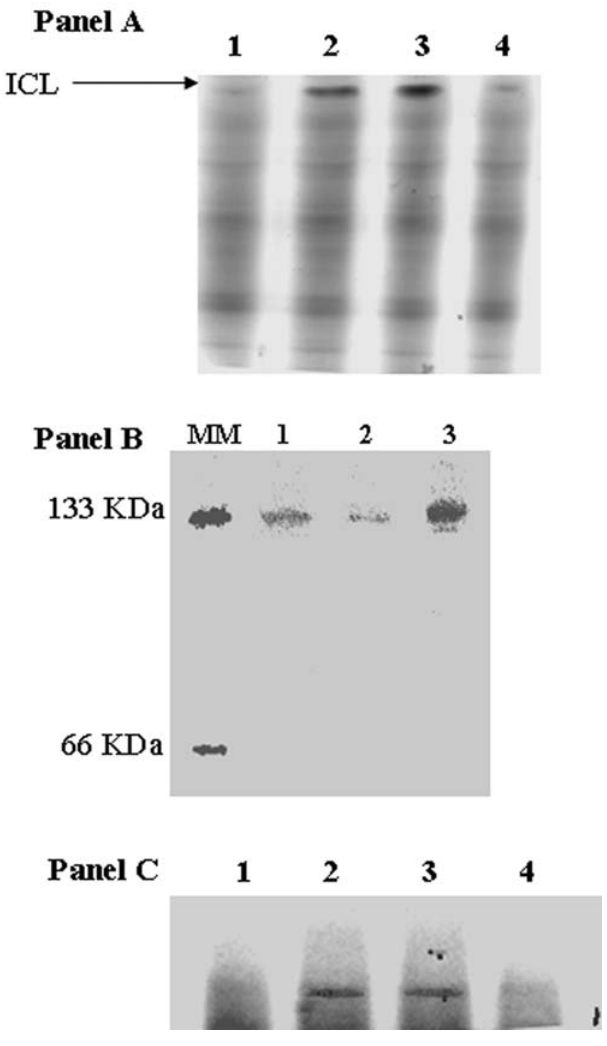
Figure 5. In-gel detection of ICL and MS activity. Panel A : The influence of menadione on ICL activity: Lanes 1, 2, 3, and 4 correspond to soluble CFE from cells grownina control medium, control cells transferred into a menadione medium, cells grown in a menadione medium, and menadione-stressed cells transferred to a control medium. Panel B : Assessment ofICL protein levels. Activitybands were excised and resolved on a 2D-Native PAGE. Lanes 1, 2, and 3 correspond to ICL purchased from Sigma, soluble CFE from control cells, and soluble CFE from menadione- stressed cells. Panel C : In-gel detection of MS activity. Lanes 1, 2, 3, and 4 correspond to the soluble CFE from cells grown in control media, control cells transferred into menadione-stressed media, menadione media, and menadione-stressed cells transferred into control media. Cells were isolated at similar growth phases (25 h for control and 30 h for menadione) unless otherwise